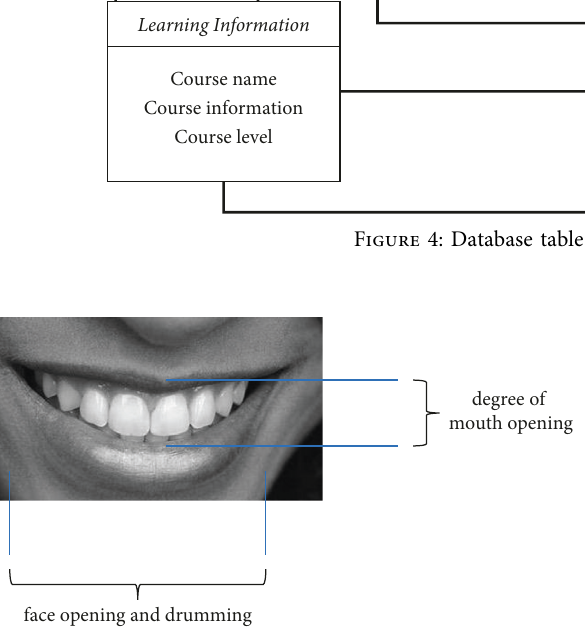
Figure 5: Main parameters of the mouthpiece.